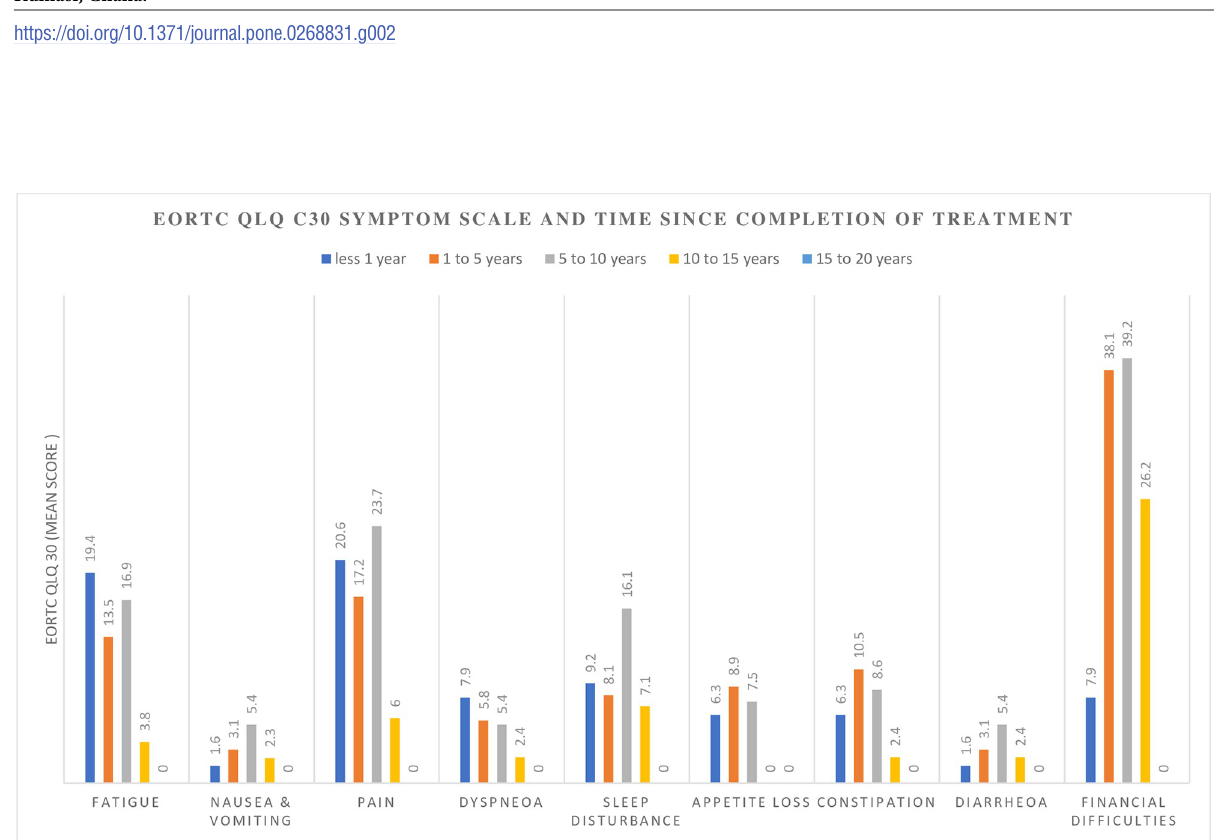
Fig 3. The change in EORTC QLQ C30 symptoms scores in the cervical cancer survivors after treatment at Komfo Anokye Teaching Hospital, Kumasi, Ghana.